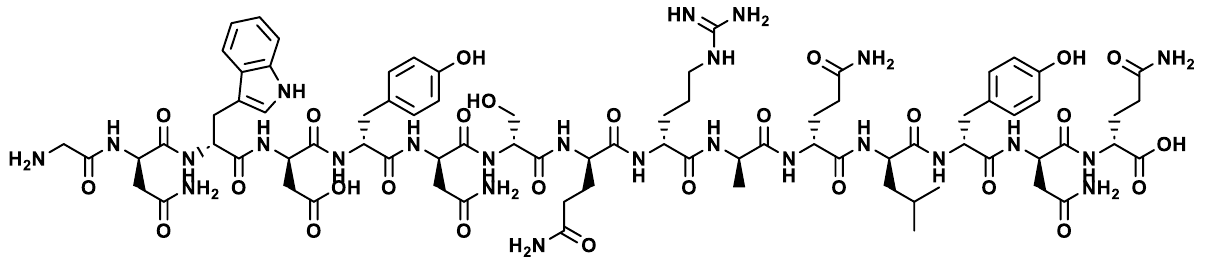
Figure 8. Sequence and structure of the most potent peptide designed, Ar5Y_4 [86].